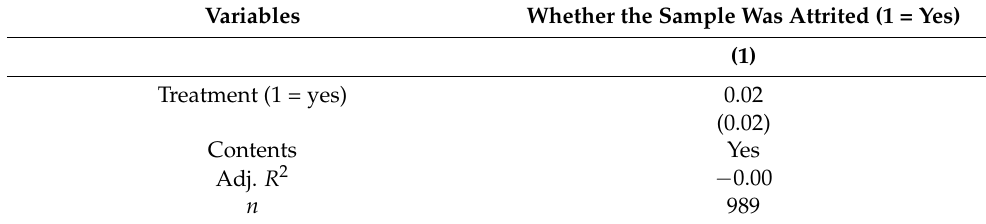
Table 2. Balanced test of the intervention on whether the sample was